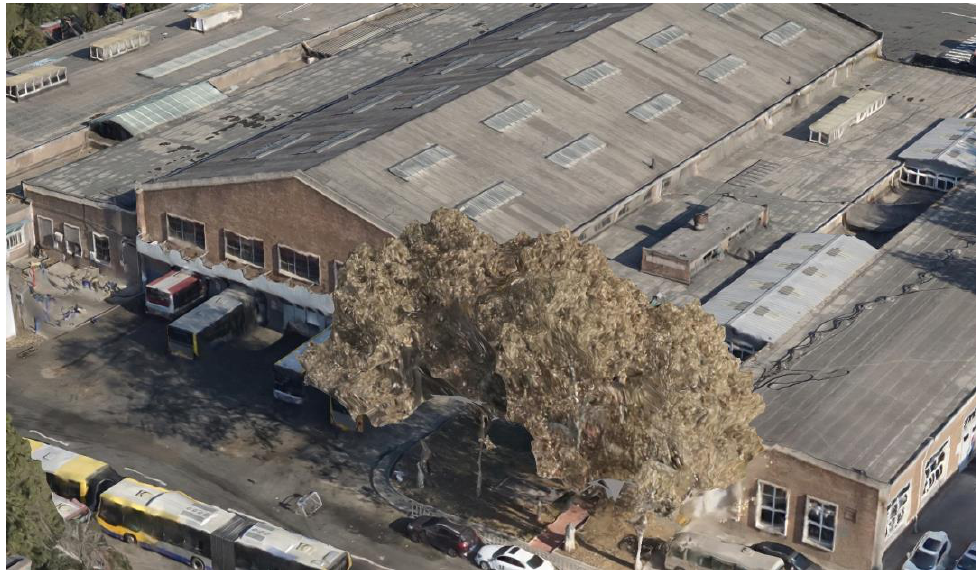
Figure 9 The big experiment area model produced by the oblique photogrammetry only